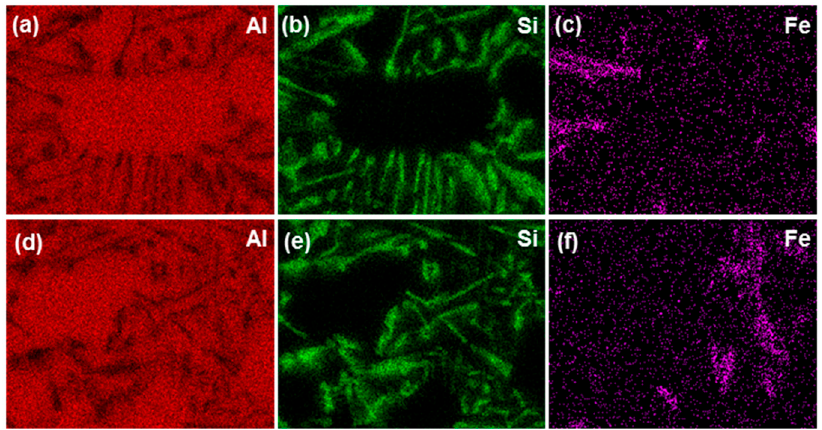
Figure 2. Energy dispersive spectrometer (EDS) area-analysis results of the Areas A and B in Figure 1. ( a , d ) Al; ( b , e ) Si; ( c , f ) Fe. Table 1. EDS analysis results (at %/wt %) of the phases denoted as 1–5 in Figure 1. No. at %/wt % Al Si Fe